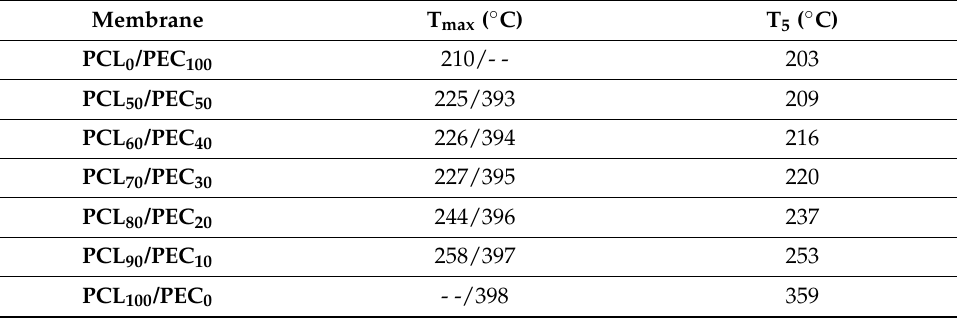
Figure 2. Thermogravimetric analysis (TGA), curves obtained for all materials obtained. ( Left ) graph shows weight loss (%) vs. temperature. ( Right ) graph shows the derivative weight loss curve (DTGA). Table 2. Thermogravimetric data for all membranes, the temperature at 5 wt% weight loss (T 5 ) and the maximum decomposition temperature (T max ) obtained from the derivative weight loss curve (DTGA).